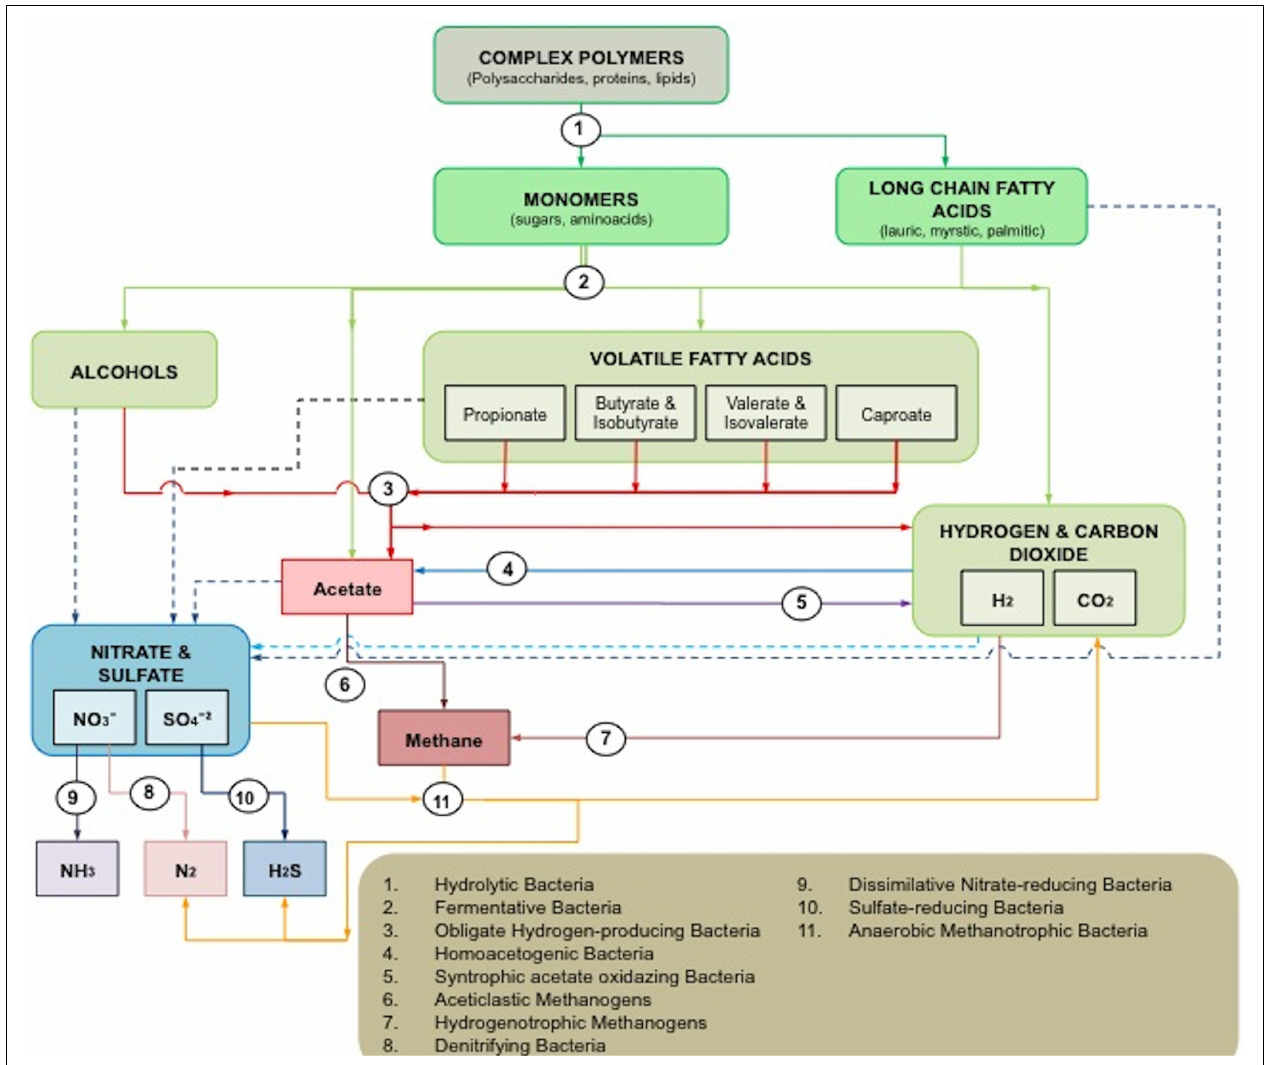
FIGURE 1 | Microbial interactions in anaerobic ecosystems. Solid lines represent the usual pathways in anaerobic digestion. Dash lines indicate alternative pathways in which the final electron acceptors are either sulfates or